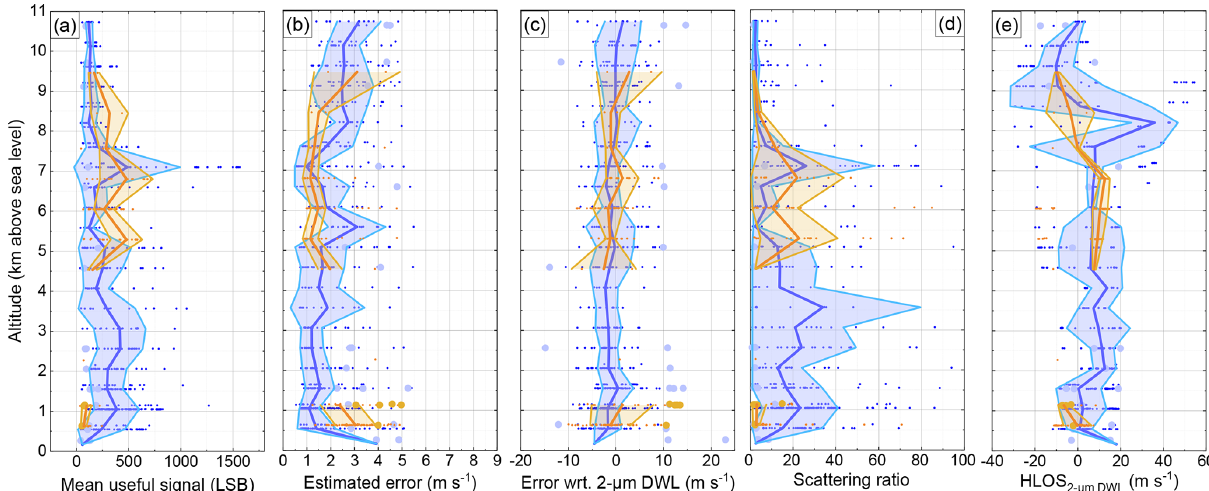
Figure 10. Dependency of the mean useful signal (a) , the estimated error (b) , the Aeolus error with respect to the 2µmDWL observations (c) , the scattering ratio (d) , and the HLOS wind velocity derived from 2µmDWL measurements (e) for Mie-cloudy wind observations available for the AVATAR-I data set (blue) and the AVATAR-T data set (orange). The actual valid data set is indicated by the small points; the outliers defined by the modified Z -score threshold of 3 are plotted by larger dots. The median value per each range gate is indicated by the solid line, and the shaded area indicates the median plus–minus the scaled MAD for each range